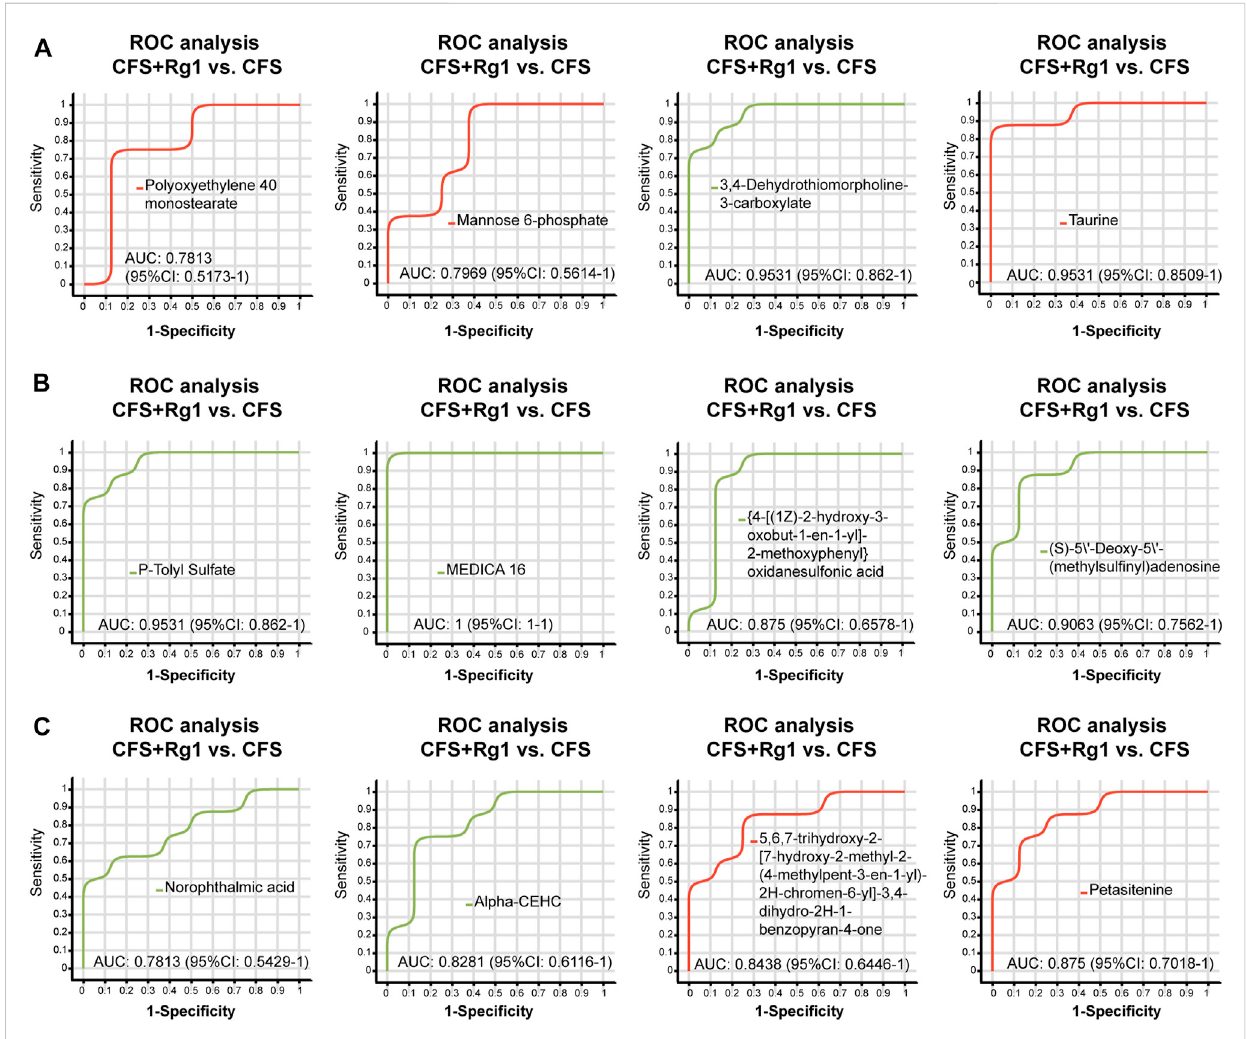
FIGURE 5 ROC curve analysis of differential metabolites (A – C) regulated by ginsenoside Rg1 (CFS + Rg1 vs. CFS). The closer the AUC is to 1, the better the diagnostic prediction. AUC has low accuracy between 0.5 and 0.7, and high accuracy above 0.7.